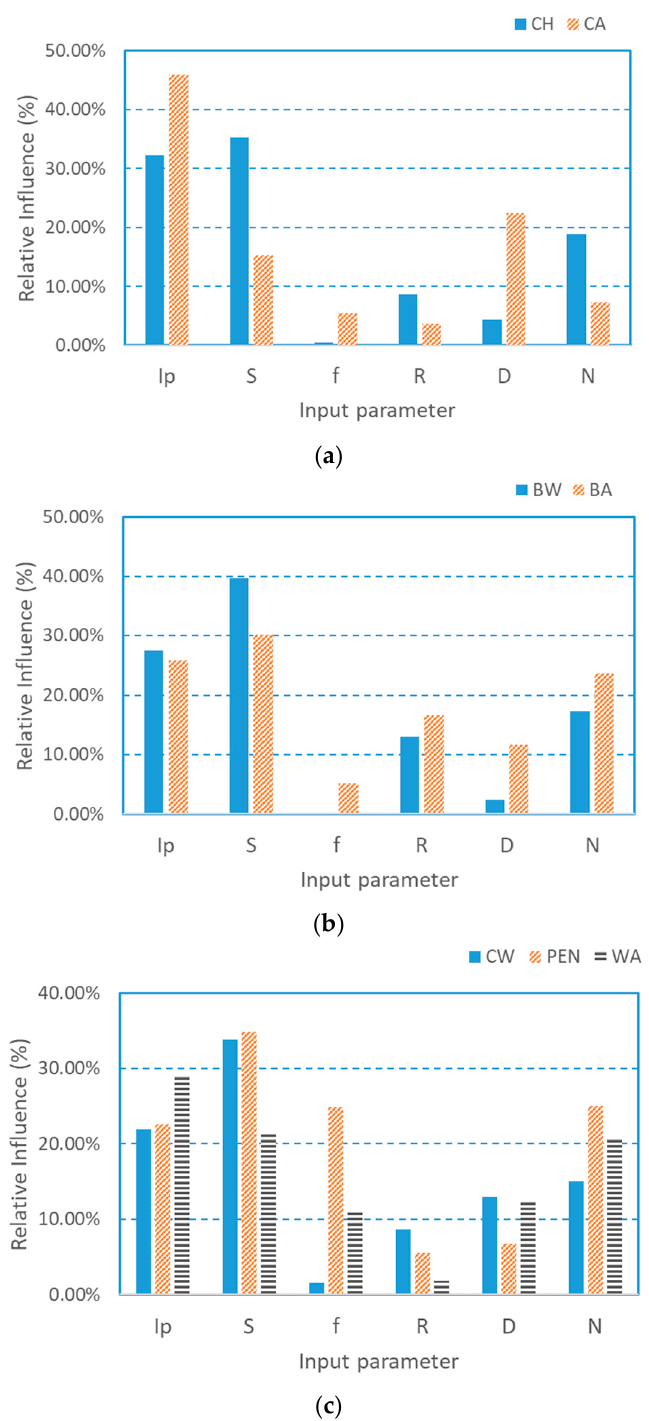
Figure 13. Relative influence of the input parameters in the outputs of the computational model obtained using connection weight approach. ( a ) Influence on CH and CA (ANN_0); ( b ) Influence on BW and BA (ANN_2); ( c ) Influence on CW, PEN and WA (ANN_A).